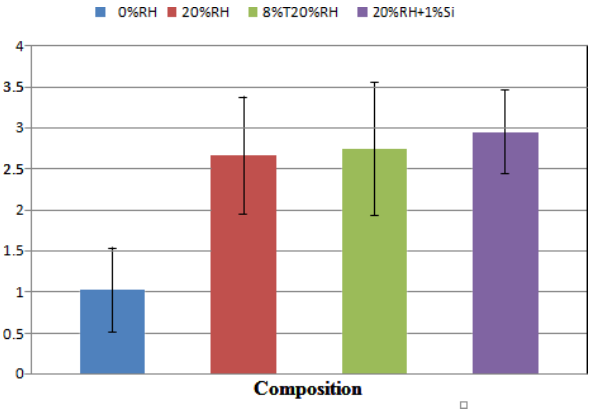
Figure 5: Comparison of fracture toughness of pure epoxy, 20 wt% untreated RH composite, 8% treated (20 wt%) and 1% Si reinforced composite